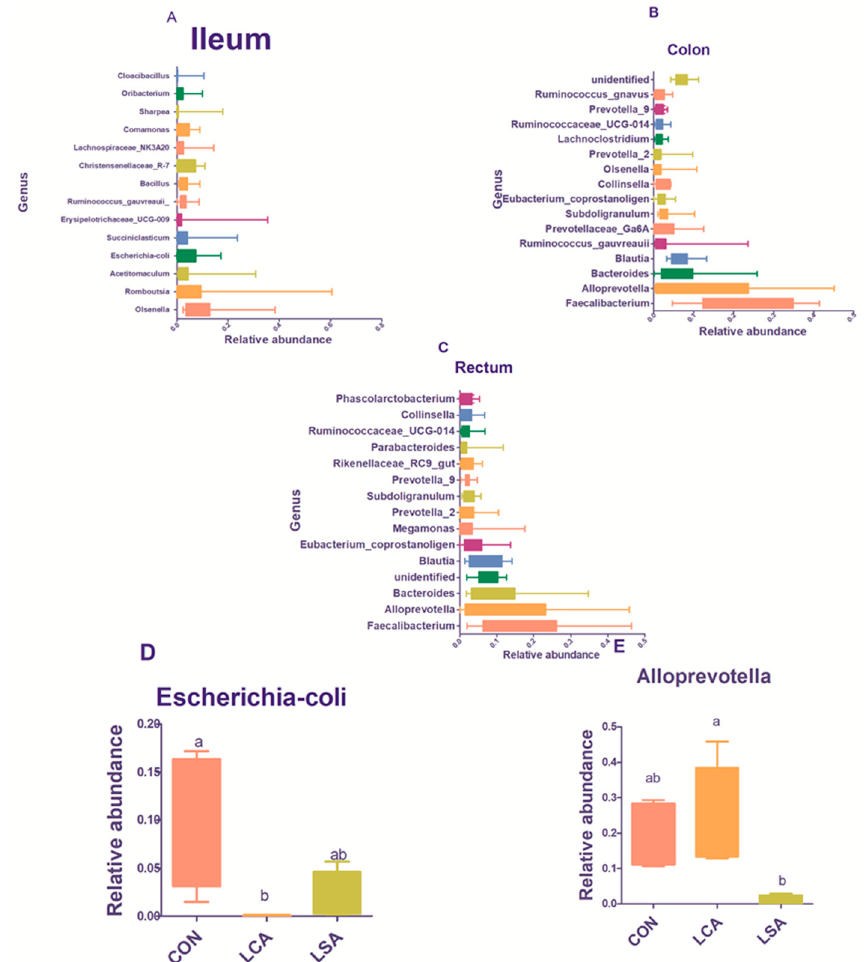
Figure 4. Effect of feeding MR antibiotics on the predominant genera in the ileum, colon and rectum samples. A = ileum; B = colon; C = rectum; D and E Comparison of the relative abundances of the significantly different genera among treatments in the ileum and rectum respectively. CON = control; LCA = low cocktail of antibiotics concentration; LSA = low concentration of single antibiotic. The values are the mean plus standard deviation. Treatments with different letters are significantly different ( P < 0.05).